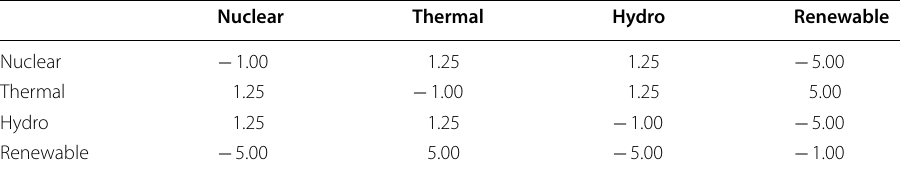
Table 9 Additional scenario for scenario 2